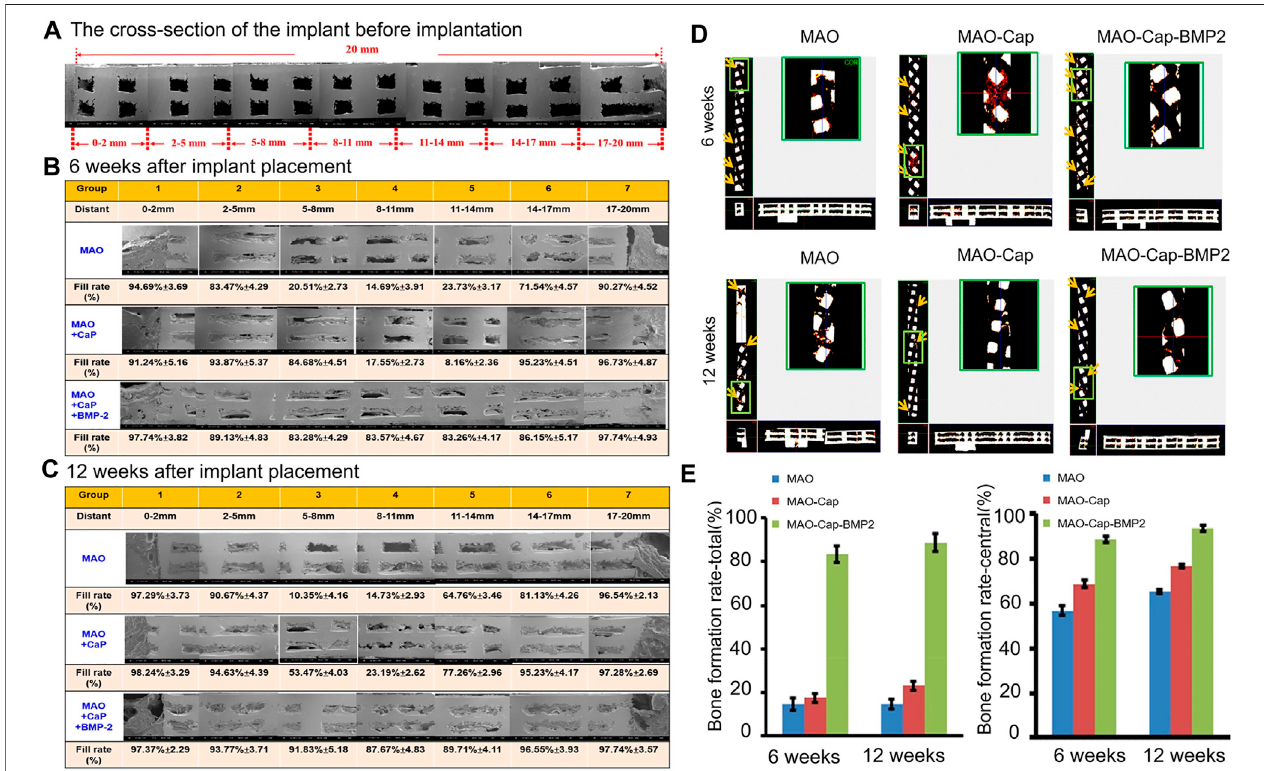
FIGURE 4 | (A) SEM image showing the cross-section of the implant before implantation. (B,C) are cross-sectional scanning electron microscope images 6 and 12 weeks after implant placement. (D) The blood vessel growth into the implant at 6 and 12 weeks observed by Micro CT. Red dots: newly formed blood vessels. (E) Using ImageJ software to estimate the bone fi lling rate of the cross-sectional scanning electron microscope image. Reprinted with permission from (Teng et al., 2019).